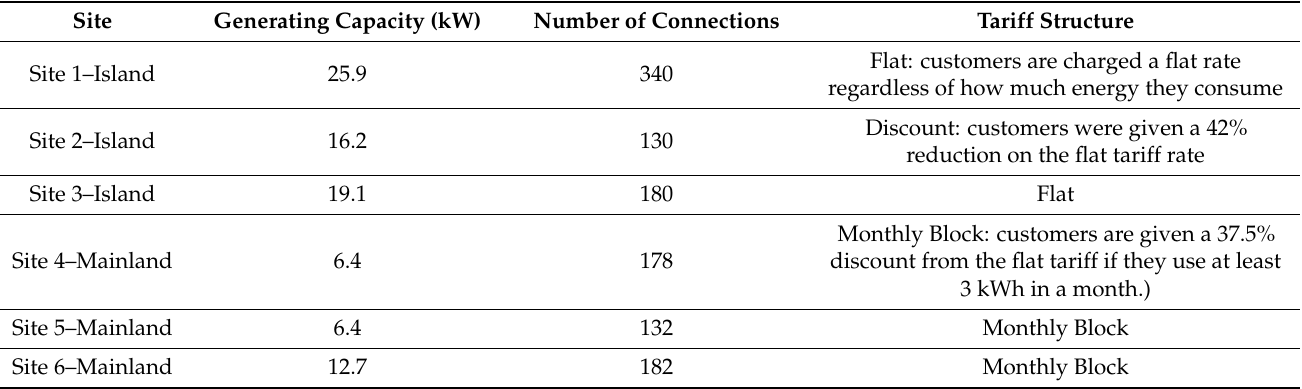
Table 1. Mini-grid sites in A2EI pilot.